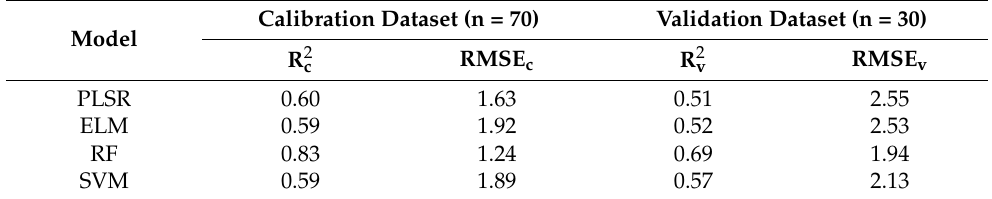
Table 5. Accuracy evaluation for inferring Ni concentration using indirect inversion models including PLSR, ELM, RF, and SVM.